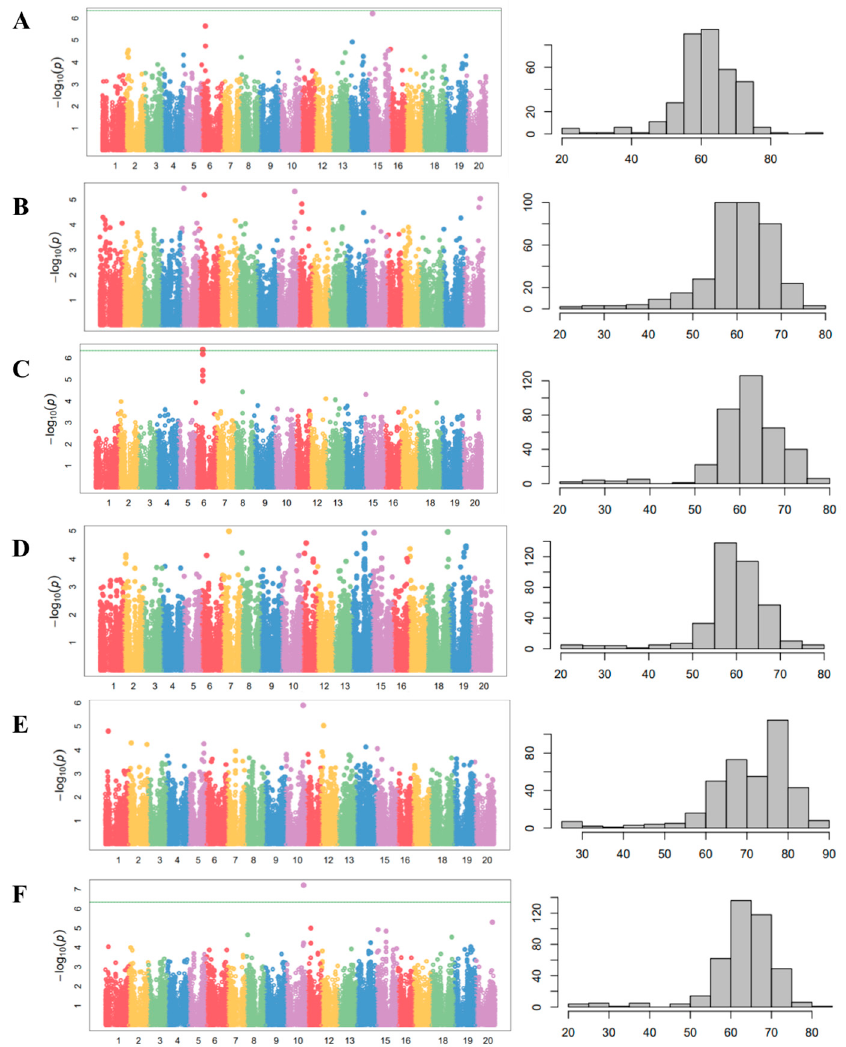
Figure 4. Manha tt an plots of CMLM analysis and phenotypic distribution for days to fl owering with Figure 4. Manhattan plots of CMLM analysis and phenotypic distribution for days to flowering 408 wild soybean accessions in 5 di ff erent environments. ( A ) Suwon, 2012. ( B ) Suwon, 2013. ( C ) with 408 wild soybean accessions in 5 different environments. ( A ) Suwon, 2012. ( B ) Suwon, 2013. Gwangju, 2016. ( D ) Jeonju, 2016. ( E ) Ochang, 2016. ( F ) The mean of fi ve environments. The horizon- ( C ) Gwangju, 2016. ( D ) Jeonju, 2016. ( E ) Ochang, 2016. ( F ) The mean of five environments. The tal green line indicates the genome-wide signi fi cance threshold based on Bonferroni correction ( p < horizontal green line indicates the genome-wide significance threshold based on Bonferroni correction 0.05). ( p <